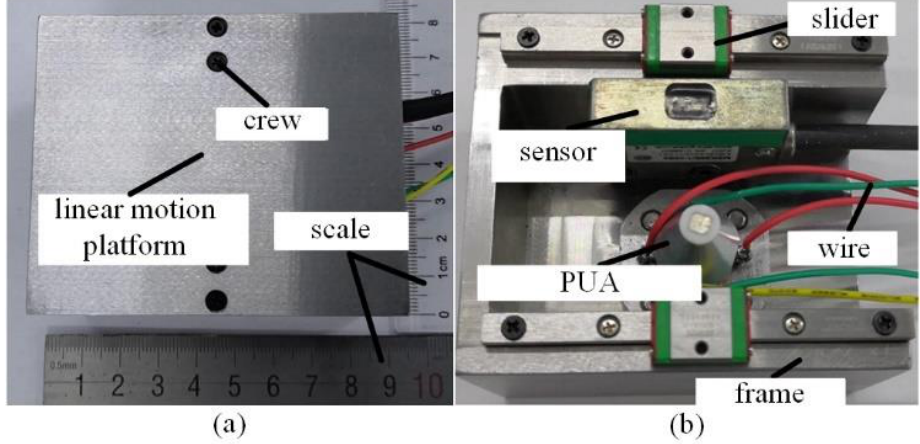
Figure 8. Linear platform system. ( a ) Appearance top view. ( b ) Internal structure.